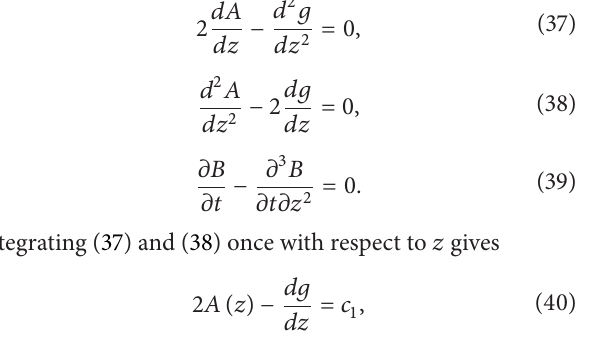
Table 1: The permeability 𝐾(𝜙) and the corresponding Lie point symmetries of